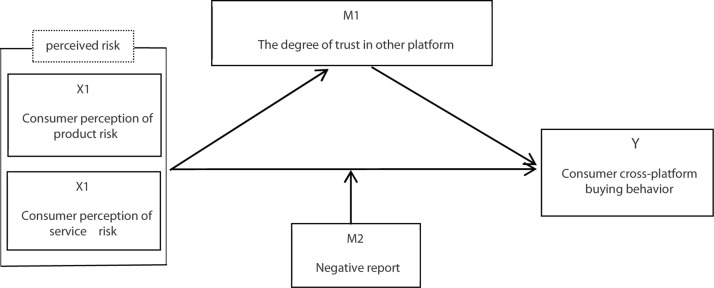
Theoretical model.